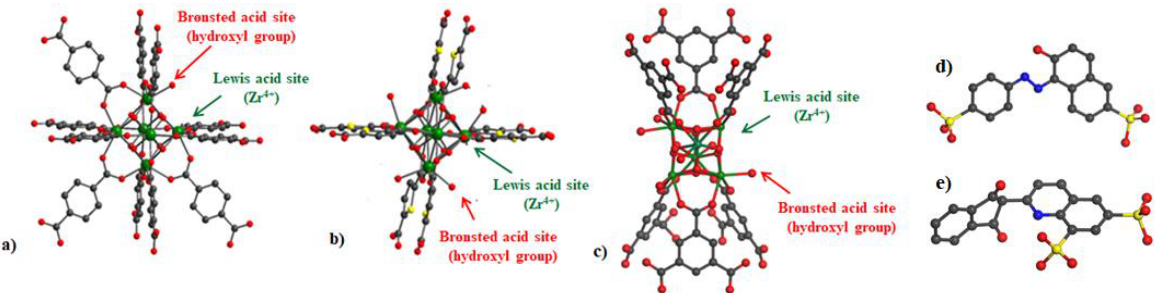
Figure 1. Representation of acidic sites, including Brønsted and Lewis acid sites, on Zr-cluster in UiO-66 framework (a typical 12-connected Zr-MOF) ( a ), DUT-67 framework (a typical 8-connected Zr-MOF) ( b ), and MOF-808 framework (a typical 6-connected Zr-MOF) ( c ), representative formulas of sunset yellow ( d ) and quinoline yellow ( e ). Color scheme: Zr (green); O (red); N (blue); S (yellow); C (grey).